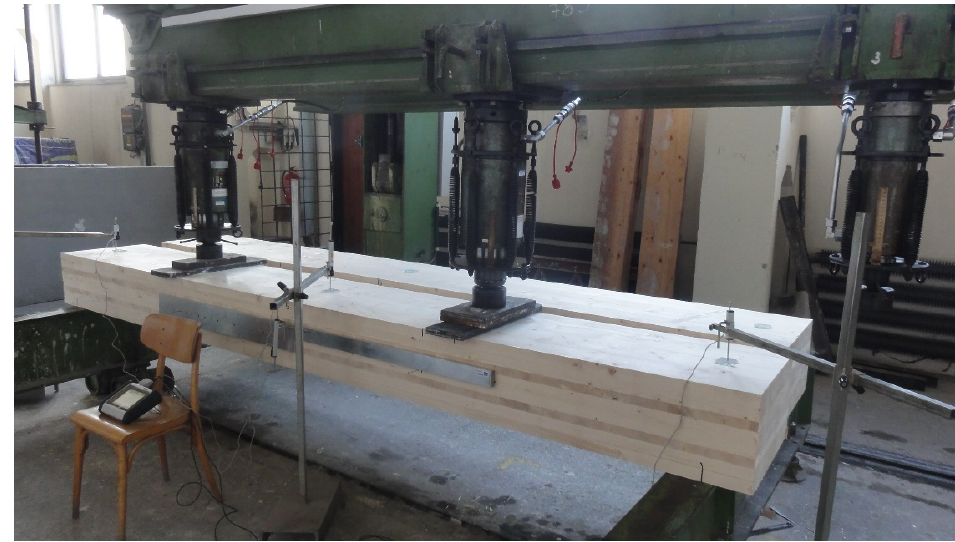
Figure 5. Test arrangement and positions of LVDTs.